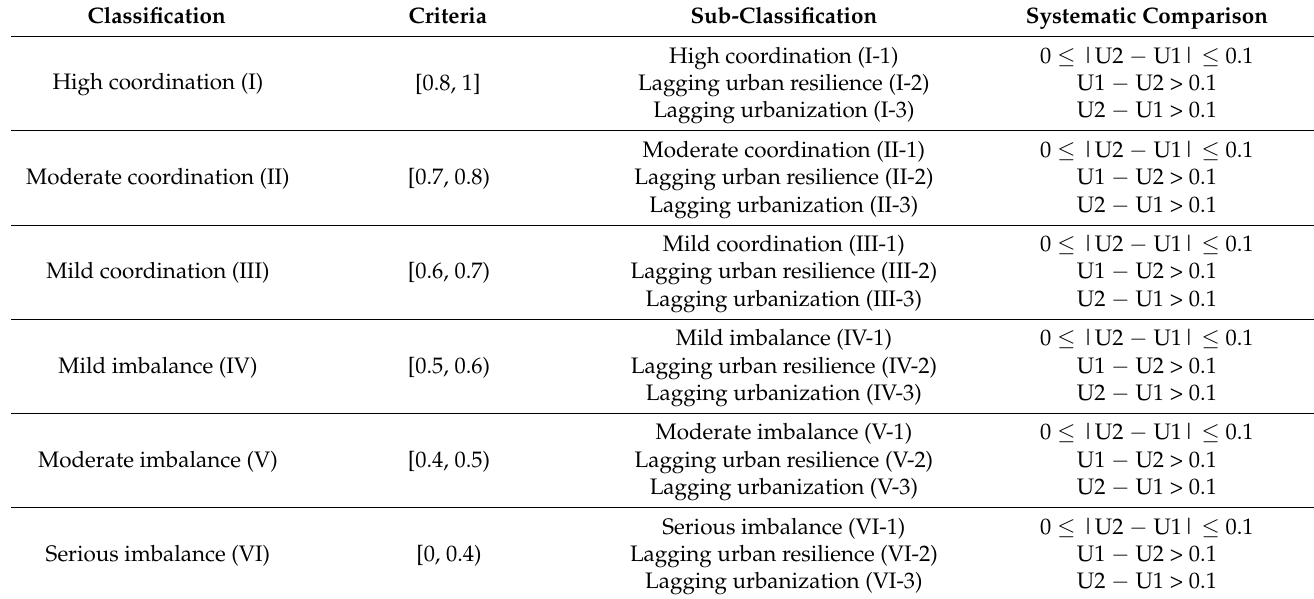
Table 5. Classification of the coupled coordination